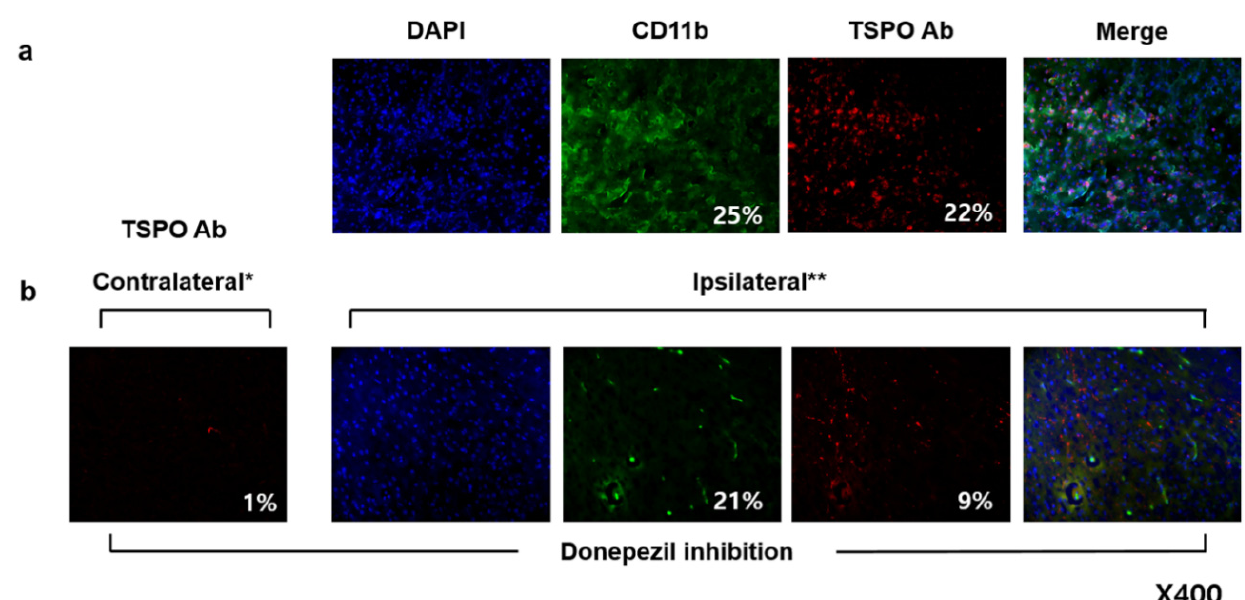
Figure 7. %ID/g ratios of [ 18 F]fluoromethyl-PBR28- d 2 ( 2 ) with, and without, donepezil treatment on day 11 after MCAO surgery ( a ). Representative TSPO PET images of respective conditions ( b ). The statistical significance of differences were determined using the Mann-Whitney U test; ** p < 0.01.